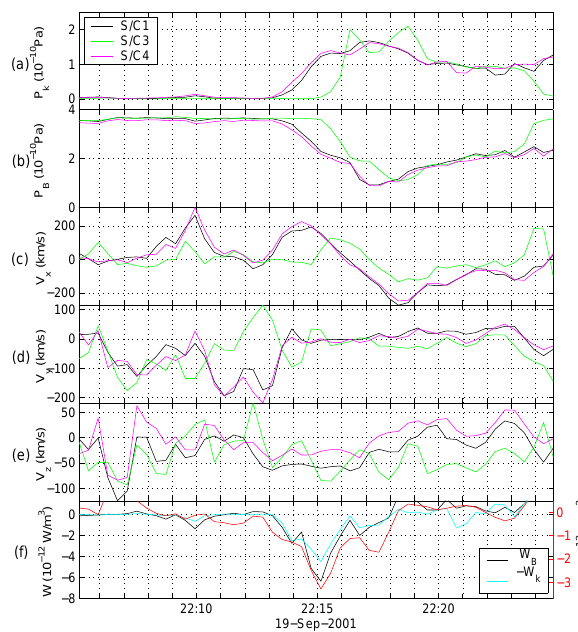
Fig. 6. Cluster data for CGR1. (a) Parallel ion pressure obtained by S/C 1, 3, and 4; (b) magnetic pressure at S/C 1, 3, and 4; (c–e) plasma flow velocities expressed in GSE x , y , and z for S/C 1, 3, and 4; (f) power density (red) together with the rate at which work is done by the ion and magnetic pressure forces, − W K and W B , respectively. Note the different scales of the power density, − W K , and W B in panel